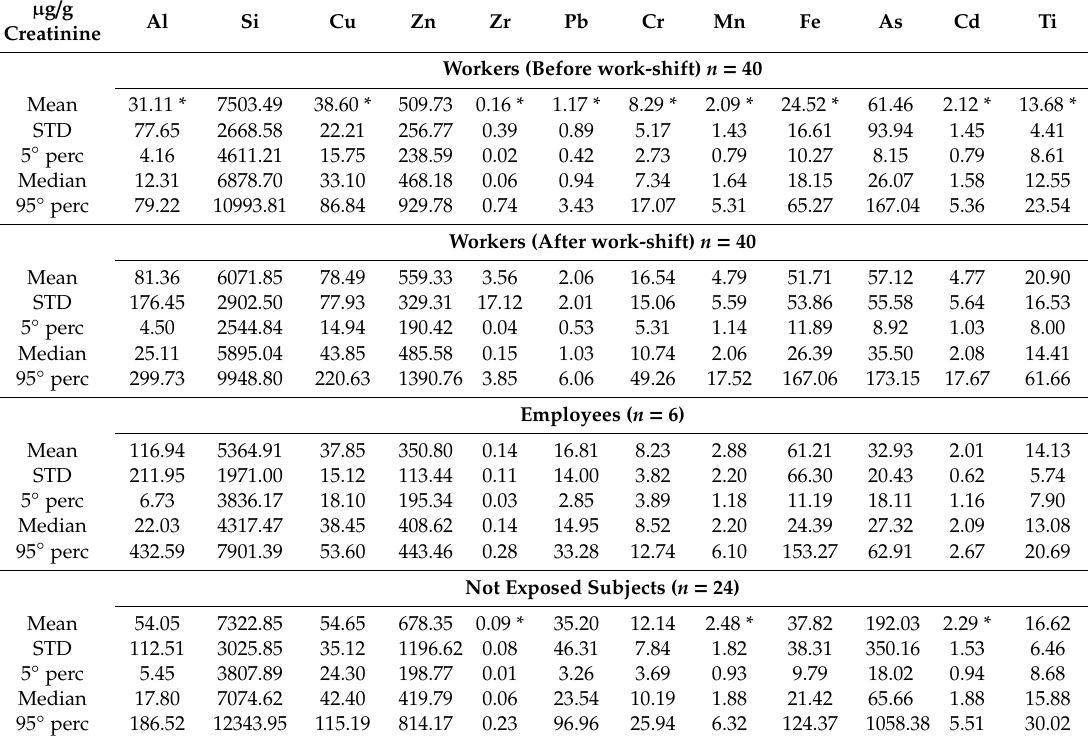
Table 2. Urinary concentrations of Titanium and other elements in workers, before and after the working shift, and in not-exposed subjects (employees and